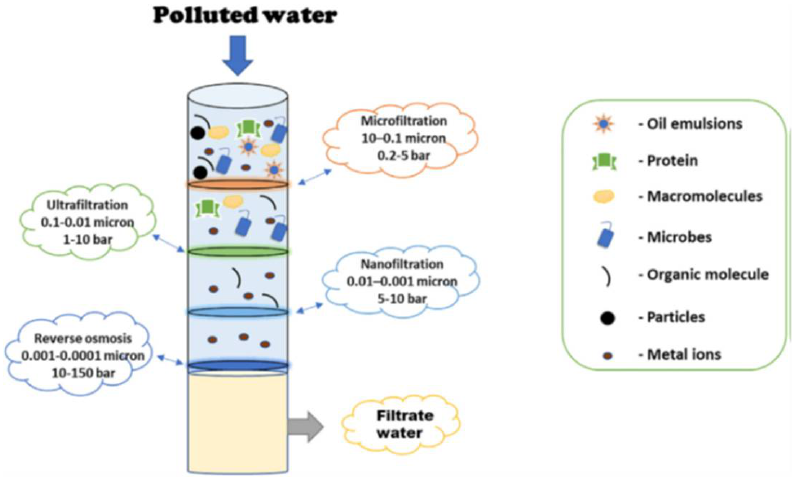
Figure 1. The schematic presentation of pressure-driven membrane for wastewater treatment [16]. Complete pore blocking, partial pore blocking, internal pore blocking, and